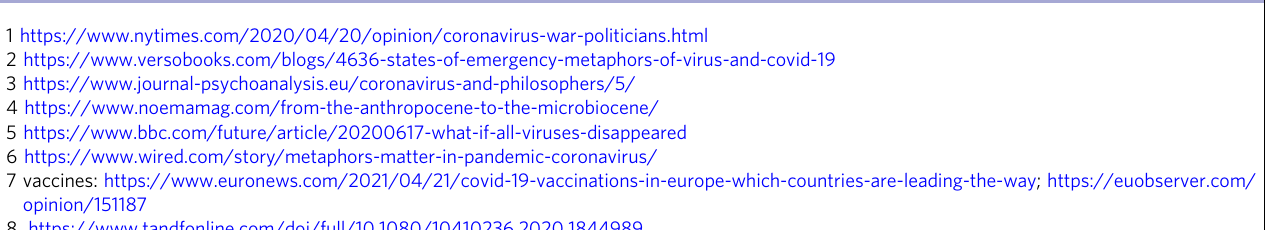
Fig. 12 General summary and contrast of the two most prevalent Covid metaphors (COVID AS WAR VS. COVID AS ENLIGHTENMENT) conveyed in mass media discourse. Table 1 List of articles analyzed for the metaphorical conceptualizations of Covid-19.